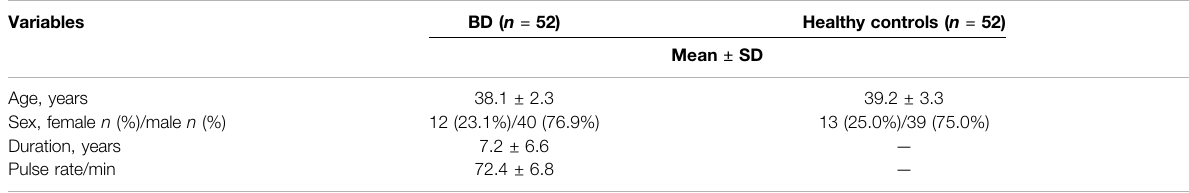
TABLE 1 | Basic characteristics of BD and control groups.